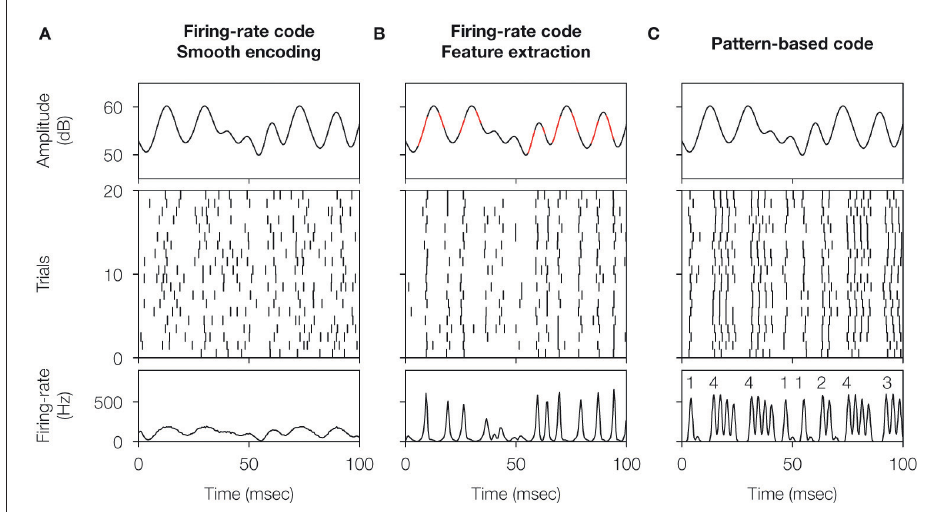
Figure 1 | Schematic comparison between different neural codes. (A) Firing-rate code, where the strength of the stimulus is encoded by the number of spikes fired in an extended time window. The temporal evolution of the firing probability (shown below) mimics the stimulus. (B) Firing-rate code, where the occurrence of specific stimulus features (in this case, pronounced upstrokes or downstrokes marked in red) is encoded in the times at which individual spikes are generated. (C) Spike-pattern code, in which different stimulus features are represented by different patterns. In this case, a burst-mediated code is shown, where different patterns are distinguished by their intra-burst spike count. The burst structure presented in this example implies strong temporal correlations between subsequent spikes. All data were obtained using model neurons. Source code is available at cabfst28.cnea.gov.ar/ eyherabh/codes.html